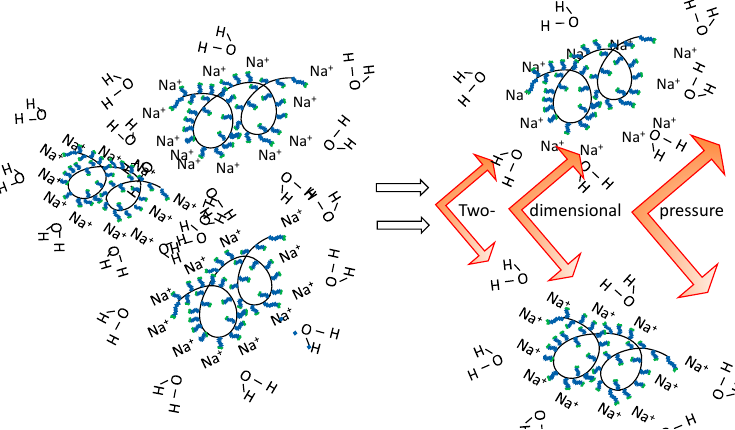
Figure 6. Two-dimensional pressure at the boundary of adsorption layers in dispersive system “CNPLUS–surfactant Tensafor”.